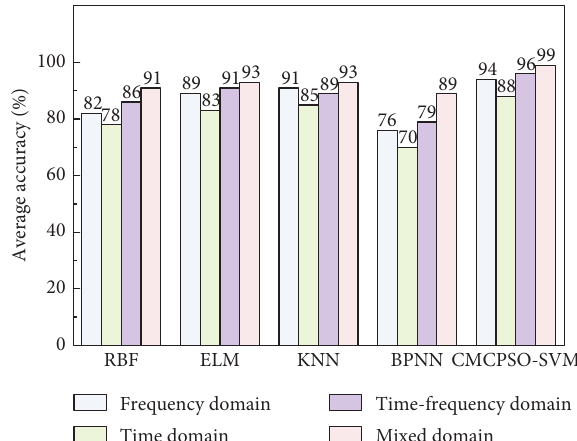
Figure 8: Average classification accuracy of different classification algorithms in different